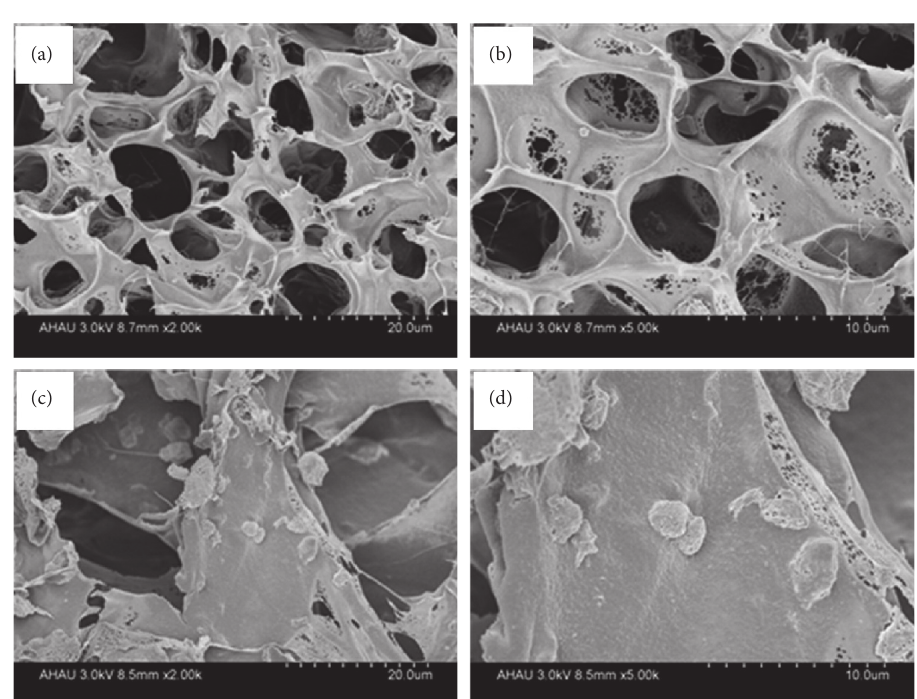
Figure 3: SEM images of SACL (a, b) before and (c, d) after adsorption of wastewater Cu (II) and Cd